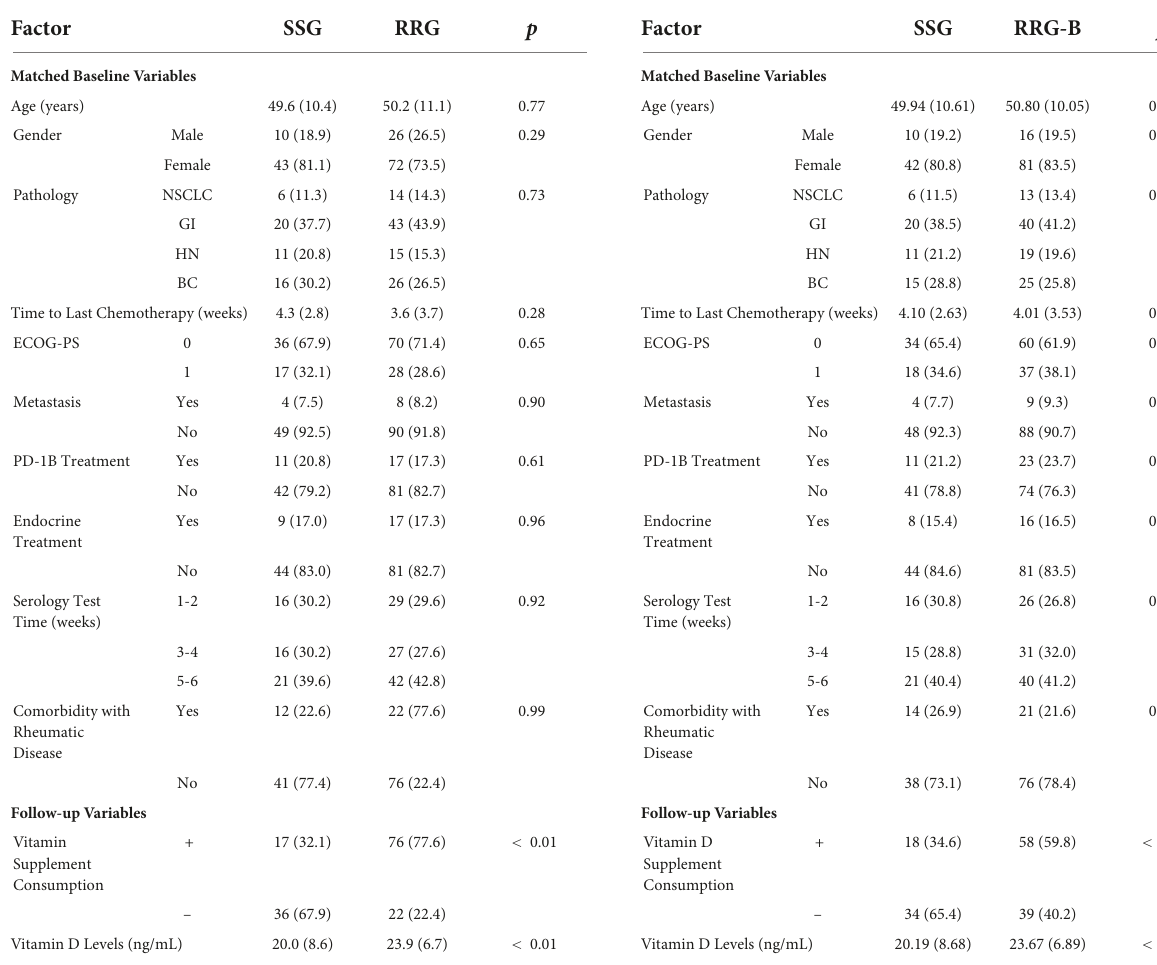
TABLE 3 Propensity score-matched comparison between serial SSG and RRG.